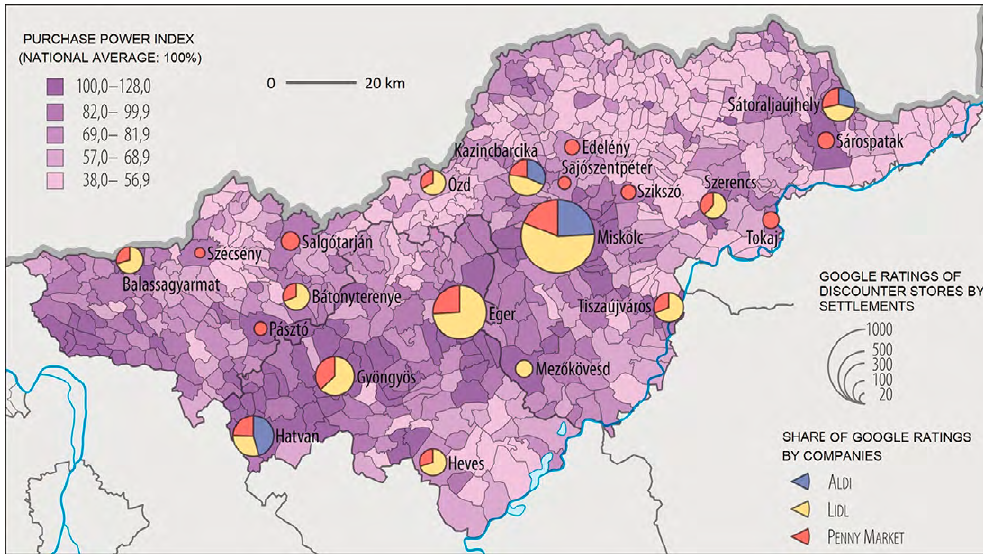
Figure 2. Discounter stores by number of Google ratings (Q3 2019*) and Purchase Power Index (2019) Source: own research, drawn by Fanni